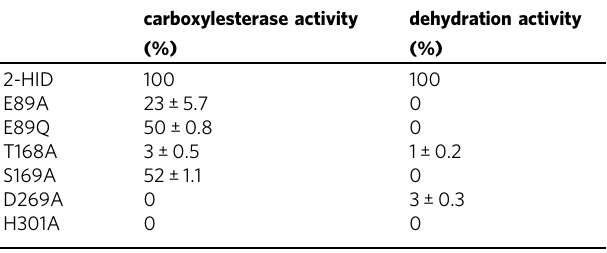
Table 3 Dehydration and carboxylesterase activity of kudzu 2-HID enzyme and